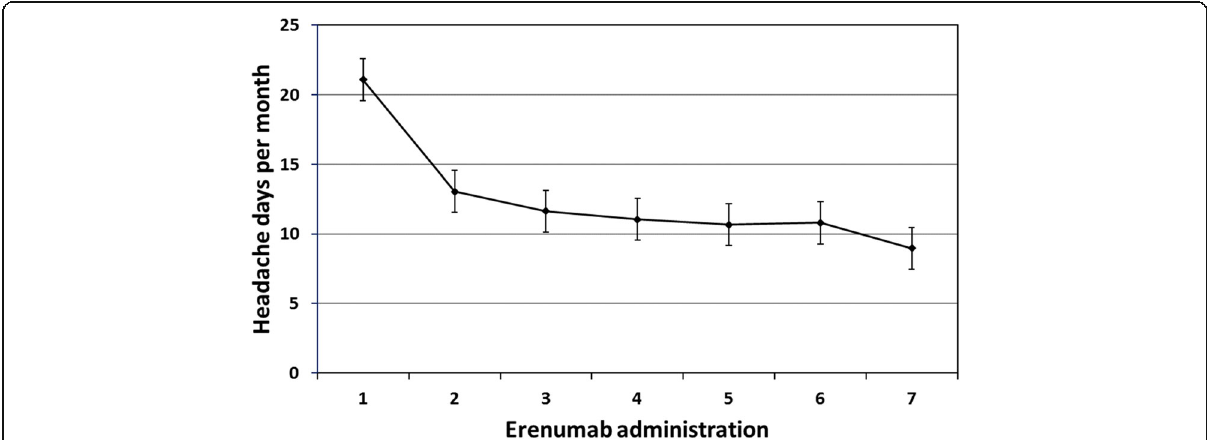
Fig. 2 Change in headache-day frequency after each erenumab